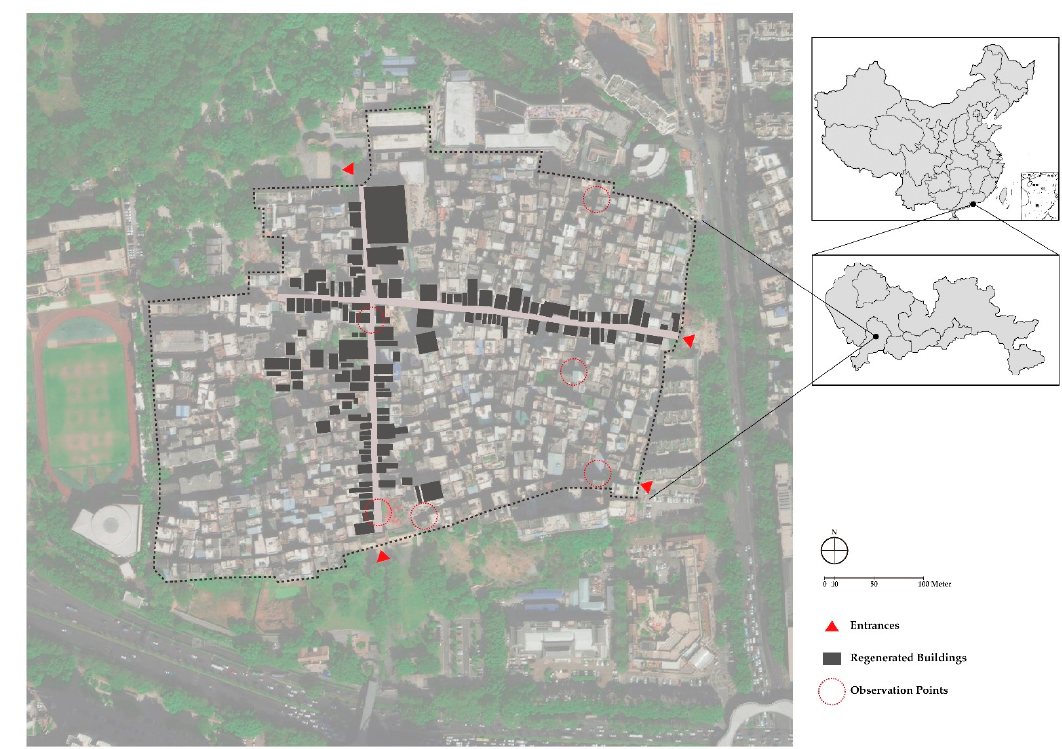
Figure 4. Nantou Old Town: ( a ) Regenerated area: Baode Square; ( b ) Generated area: Zhongshan South Street; ( c ) Unregenerated area; ( d ) Unregenerated area.